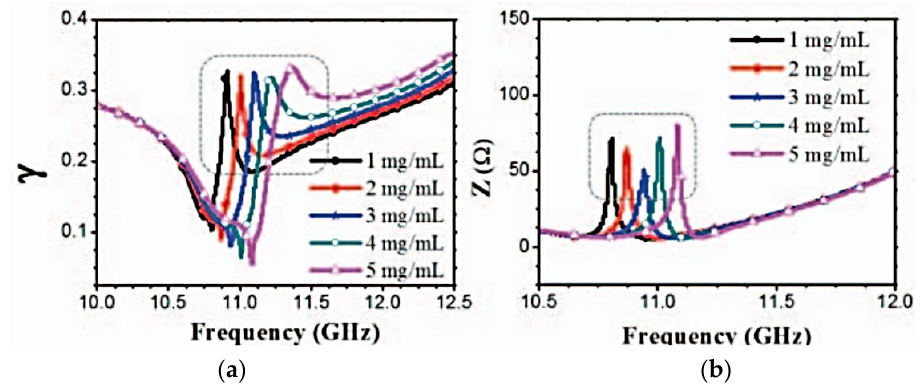
Figure 27. Detection of glucose level using derived parameters: ( a ) propagation constant ( γ ); and ( b ) impedance ( Z ) [94].